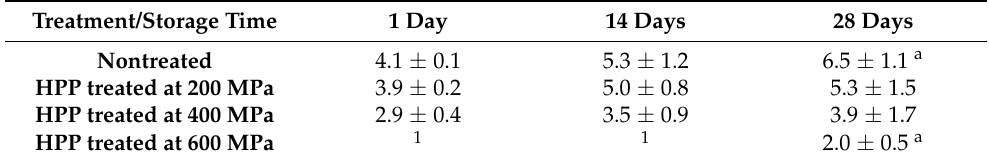
Table 2. Numbers (log 10 cfu/g) of Listeria monocytogenes colonies in inoculated warm-smoked rainbow trout samples at three (1, 14, and 28 days) different storage